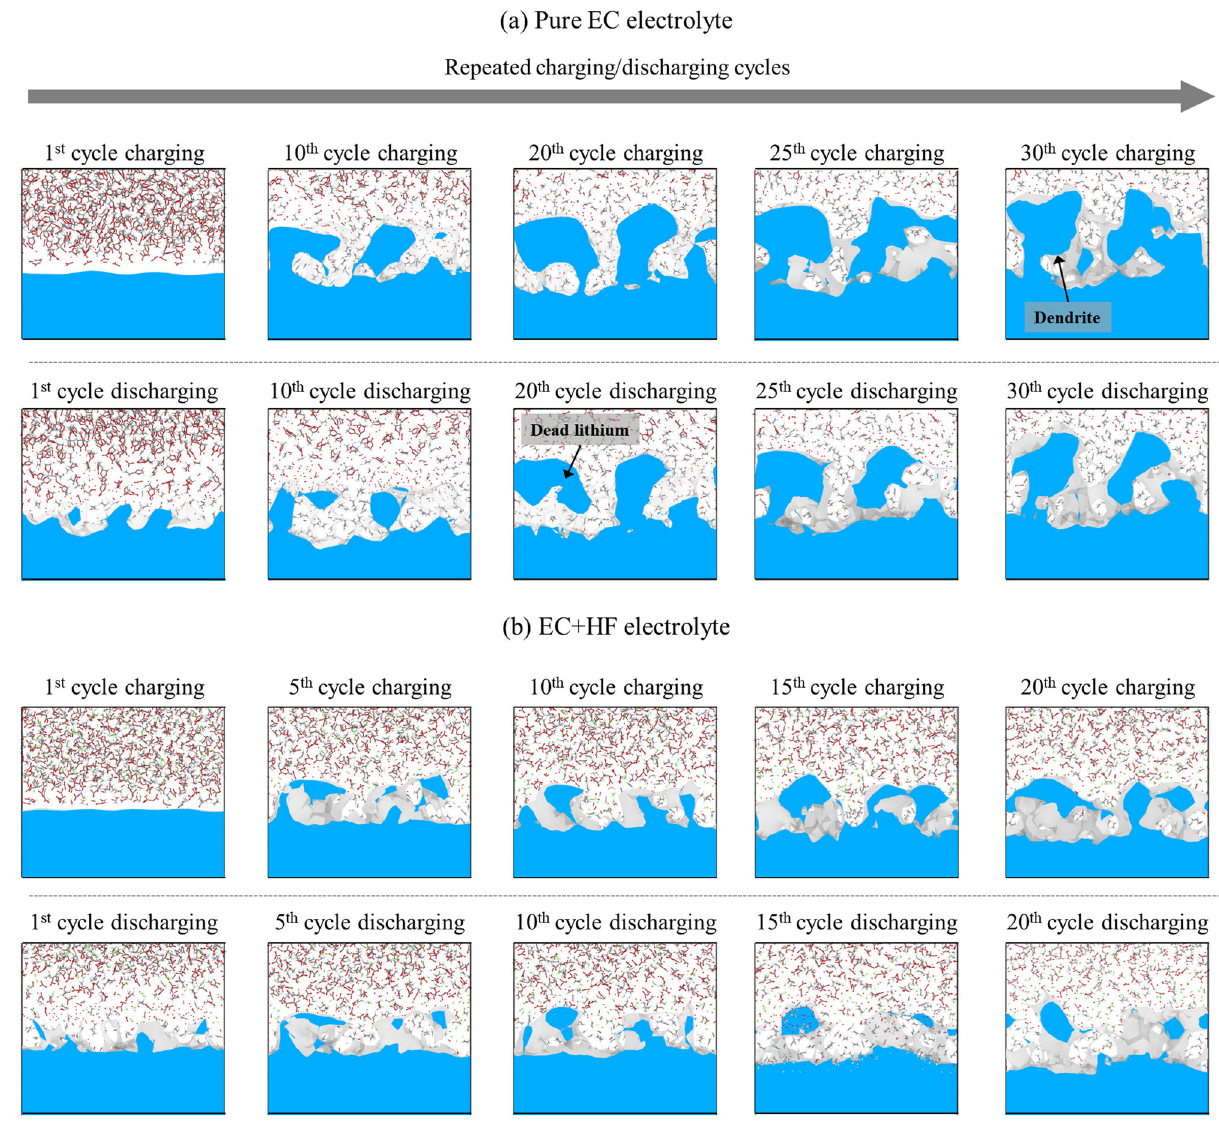
Fig. 5 Visualization of dynamic growth of dead lithium and dendrite during repeated charging-discharging cycles. a Growth of dead lithium and dendrite in pure EC electrolyte, b Suppressed growth of dead lithium and dendrite in EC + HF